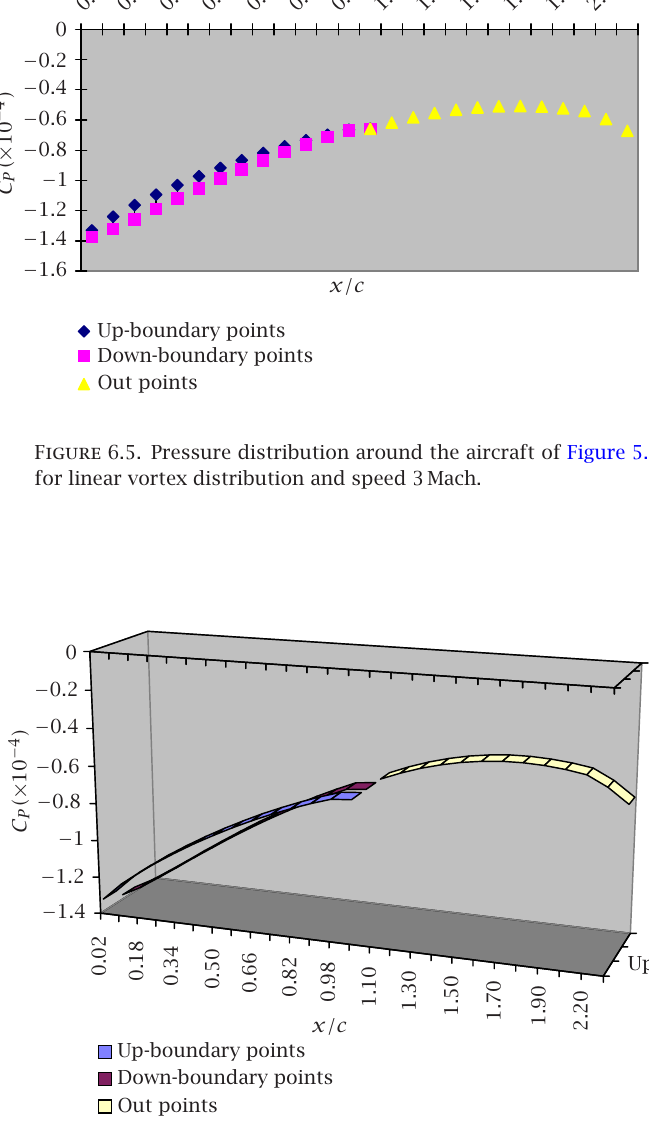
Figure 6.6 . Pressure distribution (3D form) around the aircraft of Figure 5.1, for linear vortex distribution and speed